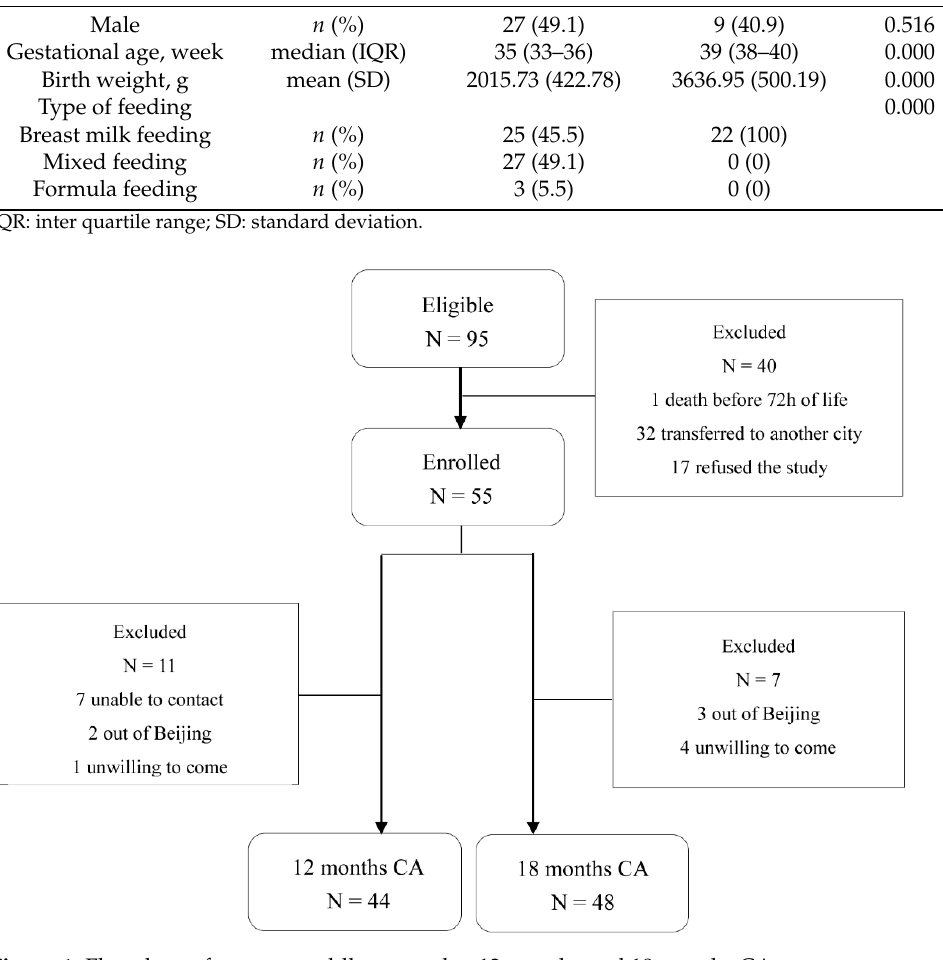
Figure 1. Flowchart of preterm toddlers tested at 12 months and 18 months CA. Table 2. Clinical and sociodemographic characteristics of study population at 12 and 18 months CA.